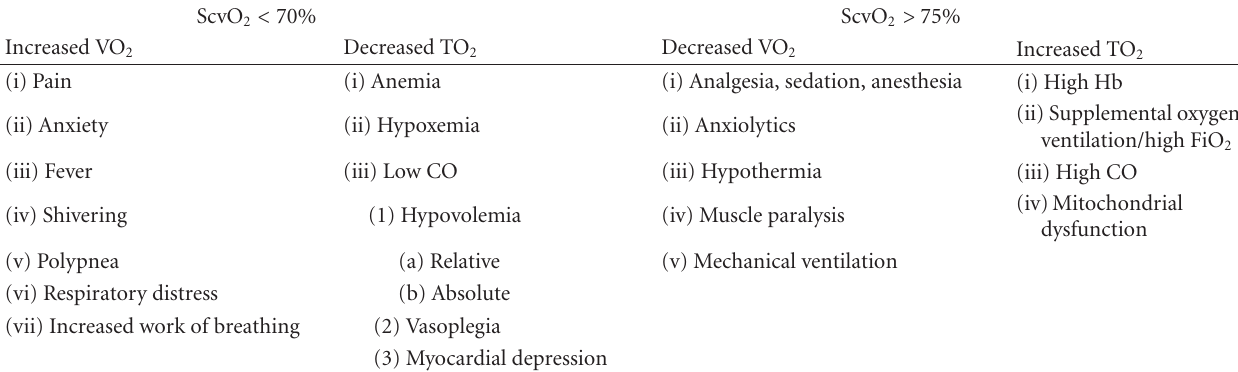
Table 1: ScvO 2 variations related to causes of TO 2 and/or VO 2 variations.